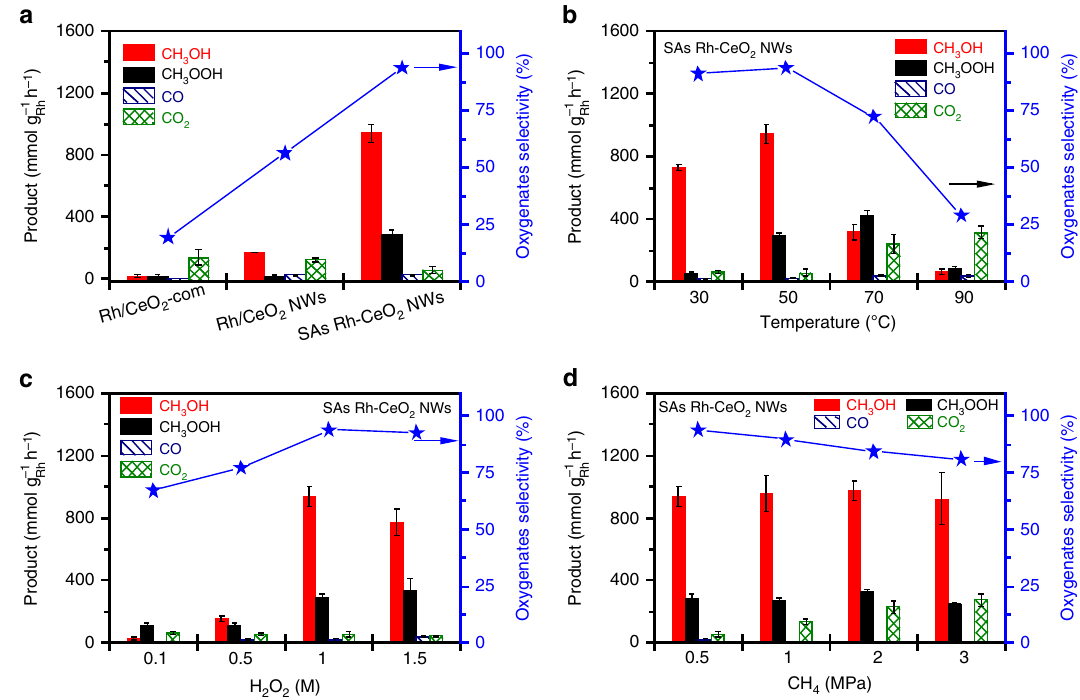
Fig. 2 DMC performance on different catalysts. a The yield and selectivity of oxygenates from Rh/CeO 2 -com, Rh/CeO 2 NWs, and SAs Rh-CeO 2 NWs. Reaction conditions: P CH4 : 0.5 MPa, H 2 O 2 : 20 mL (1 M), T : 50 °C, reaction time: 1 h, and catalyst weight: 10 mg. b DMC performance at different temperatures over SAs Rh-CeO 2 NWs. Reaction conditions: P CH4 : 0.5 MPa, H 2 O 2 : 20 mL (1 M), T : 30-90 °C, reaction time: 1 h, and catalyst weight: 10 mg. c DMC performance at different H 2 O 2 concentrations over SAs Rh-CeO 2 NWs. Reaction conditions: P CH4 : 0.5 MPa, H 2 O 2 : 20 mL (0.1 – 1.5 M), T : 50 °C, reaction time: 1 h, and catalyst weight: 10 mg. d DMC performance at different CH 4 partial pressure over SAs Rh-CeO 2 NWs. Reaction conditions: P CH4 : 0.5 – 3 MPa, H 2 O 2 : 20 mL (1 M), T : 50 °C, reaction time: 1 h, and catalyst weight: 10 mg. The error bars are de fi ned as standard deviation of three